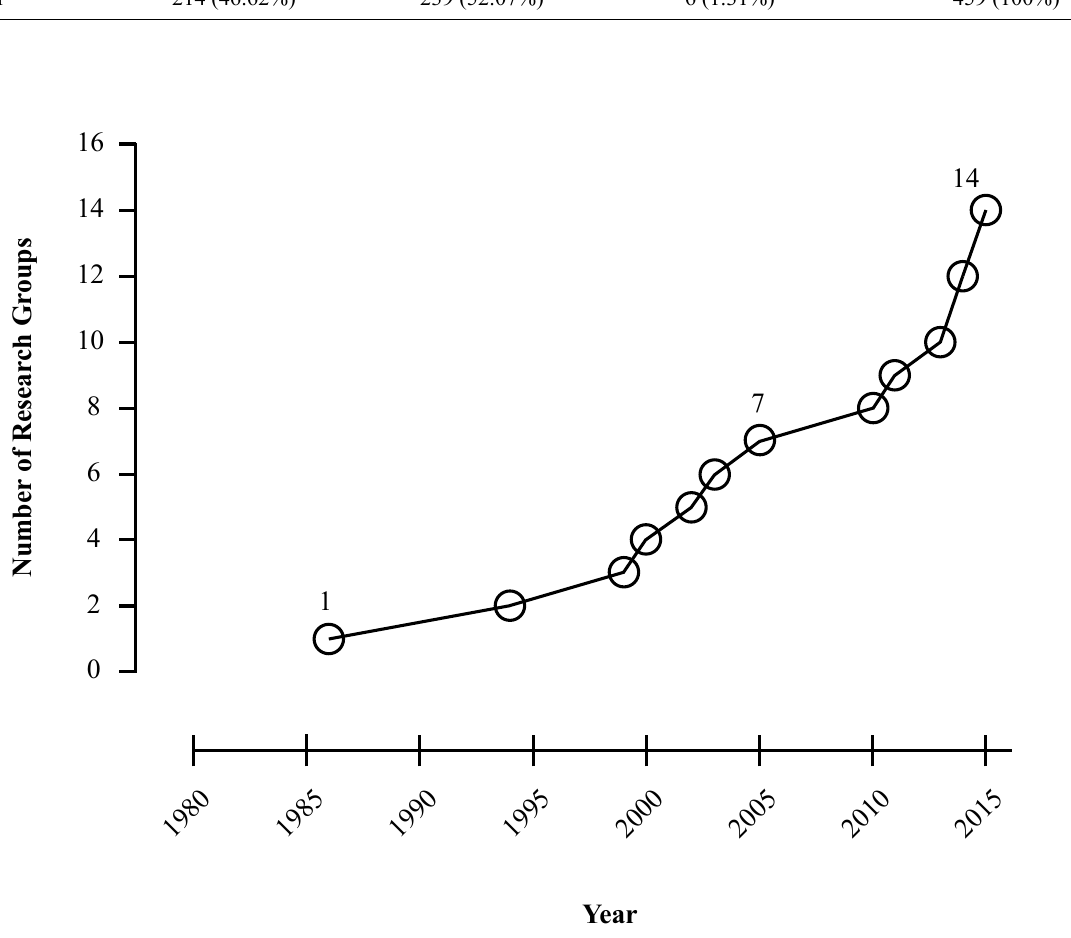
Figure 2. Evolution of the number of Brazilian research groups on interventions with diet and physical exercise in cancer. Source: Directory of Research Groups of the National Council for Scientific and Technological Development (CNPq).